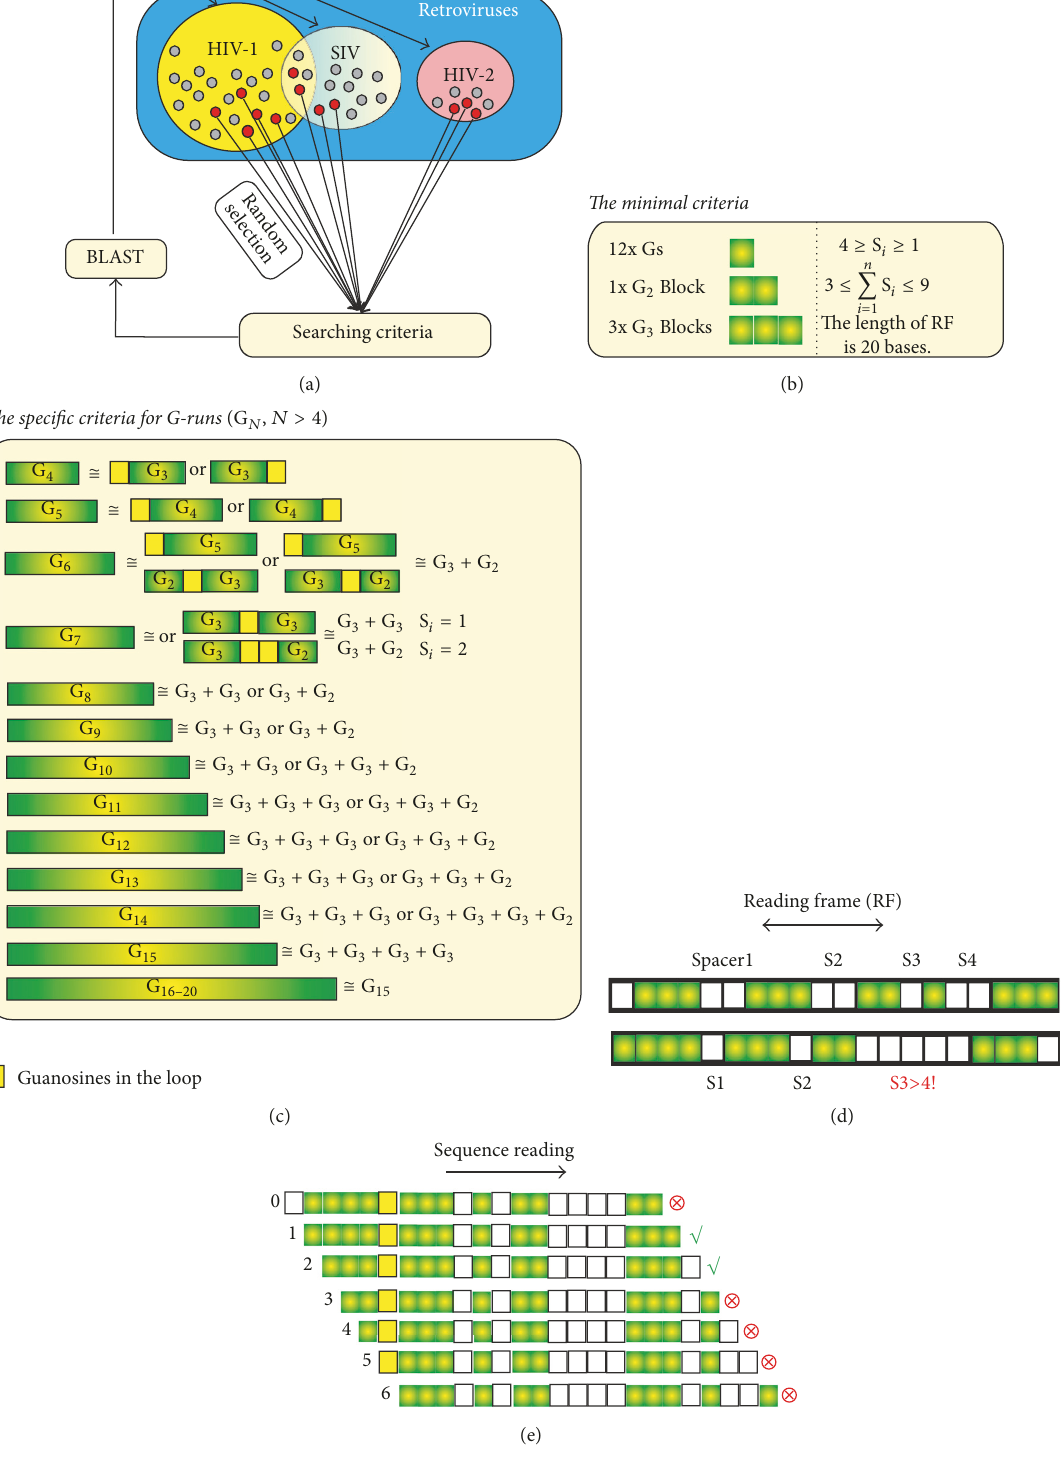
7 is formed of either two G 3